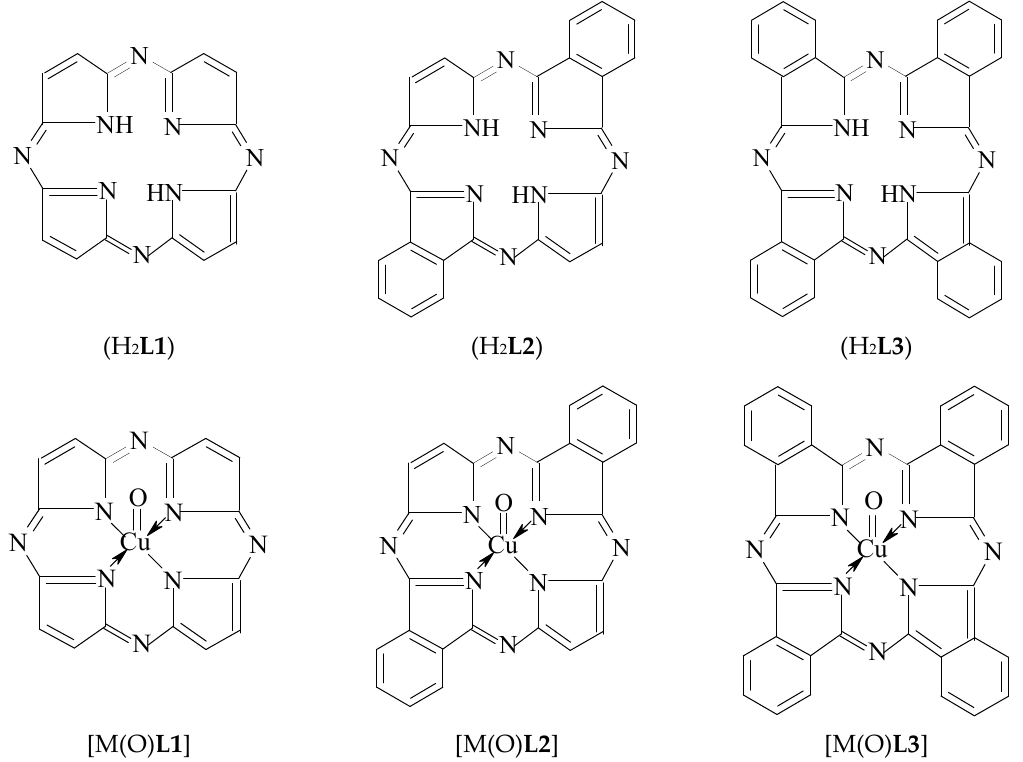
Figure 1. Structural formulas of macrocyclic ligands H 2 L1, H 2 L2 and H 2 L3 and copper complexes formed by them and oxo-anions 2. Calculation Method.